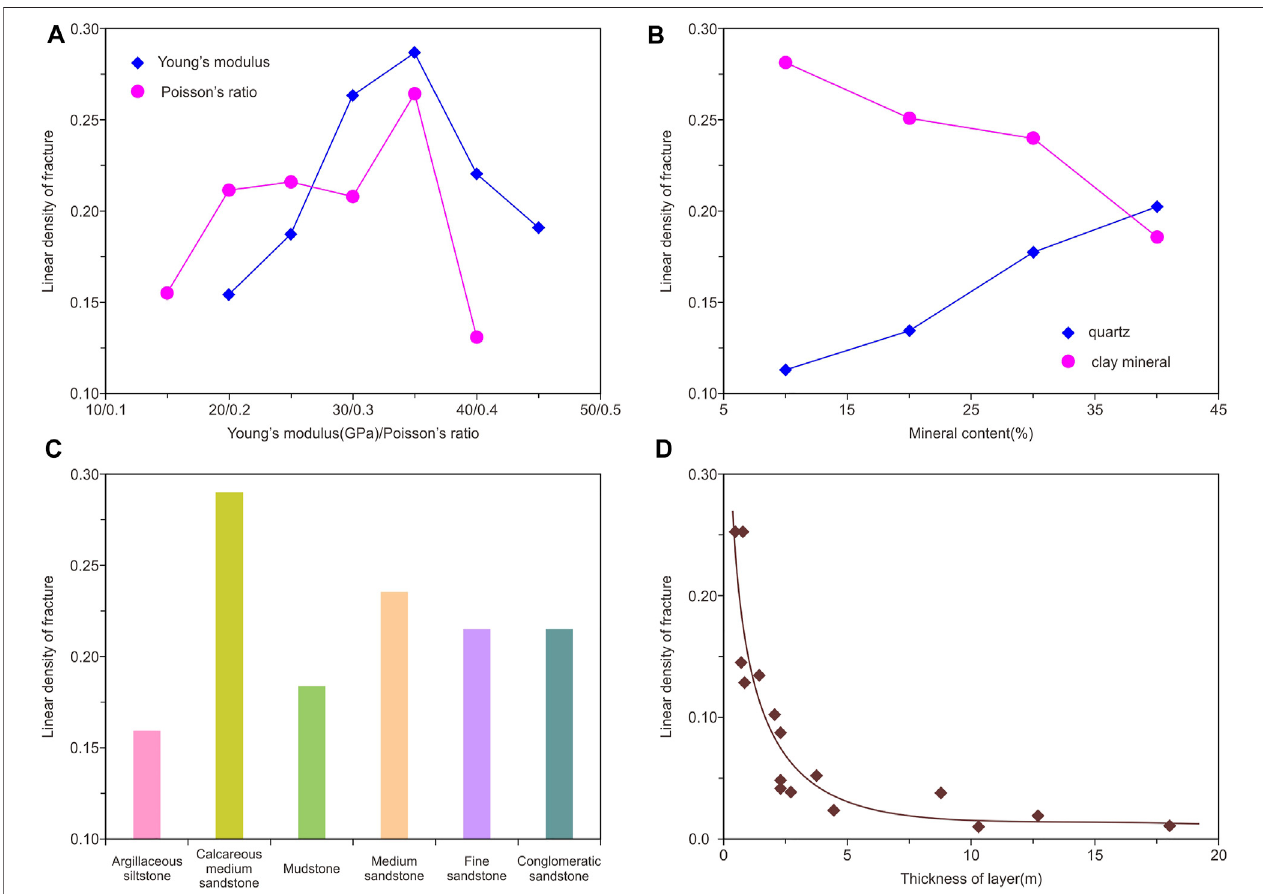
FIGURE 13 | Relationship between linear density of fractures and in fl uencing factors in LD-A gas fi eld. (A) The rock mechanics parameters and linear density of fractures, (B) the mineralogy versus linear density offractures, (C) the lithology and linear density of fractures, and (D) the relationship between linear density offractures and the